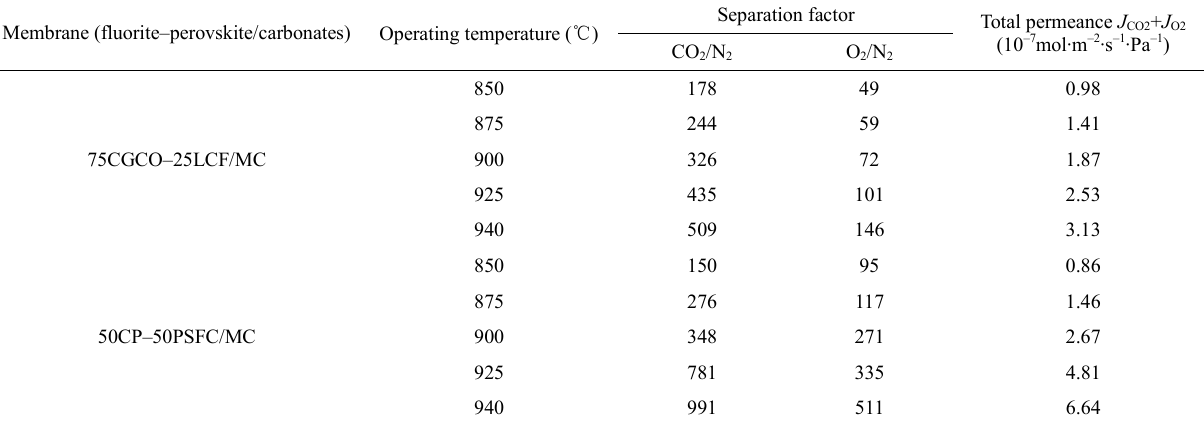
Table 3 Separation factor and observed total permeance values ( J CO2 + J O2 ) Membrane (fluorite–perovskite/carbonates)